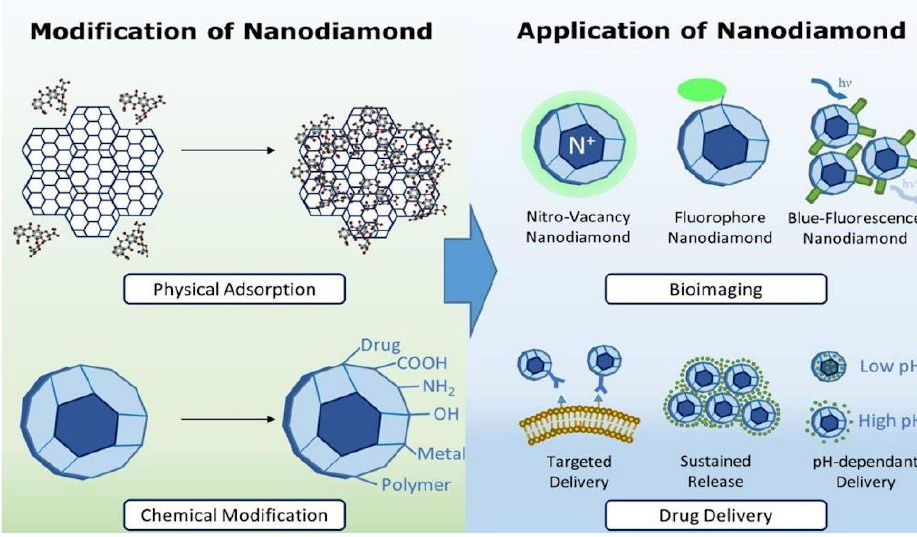
Figure 3. Schematic representation showing the use of combinatorial nanodiamonds in pharmaceutical and biomedical applications [42]. Copyright 2016, Elsevier.